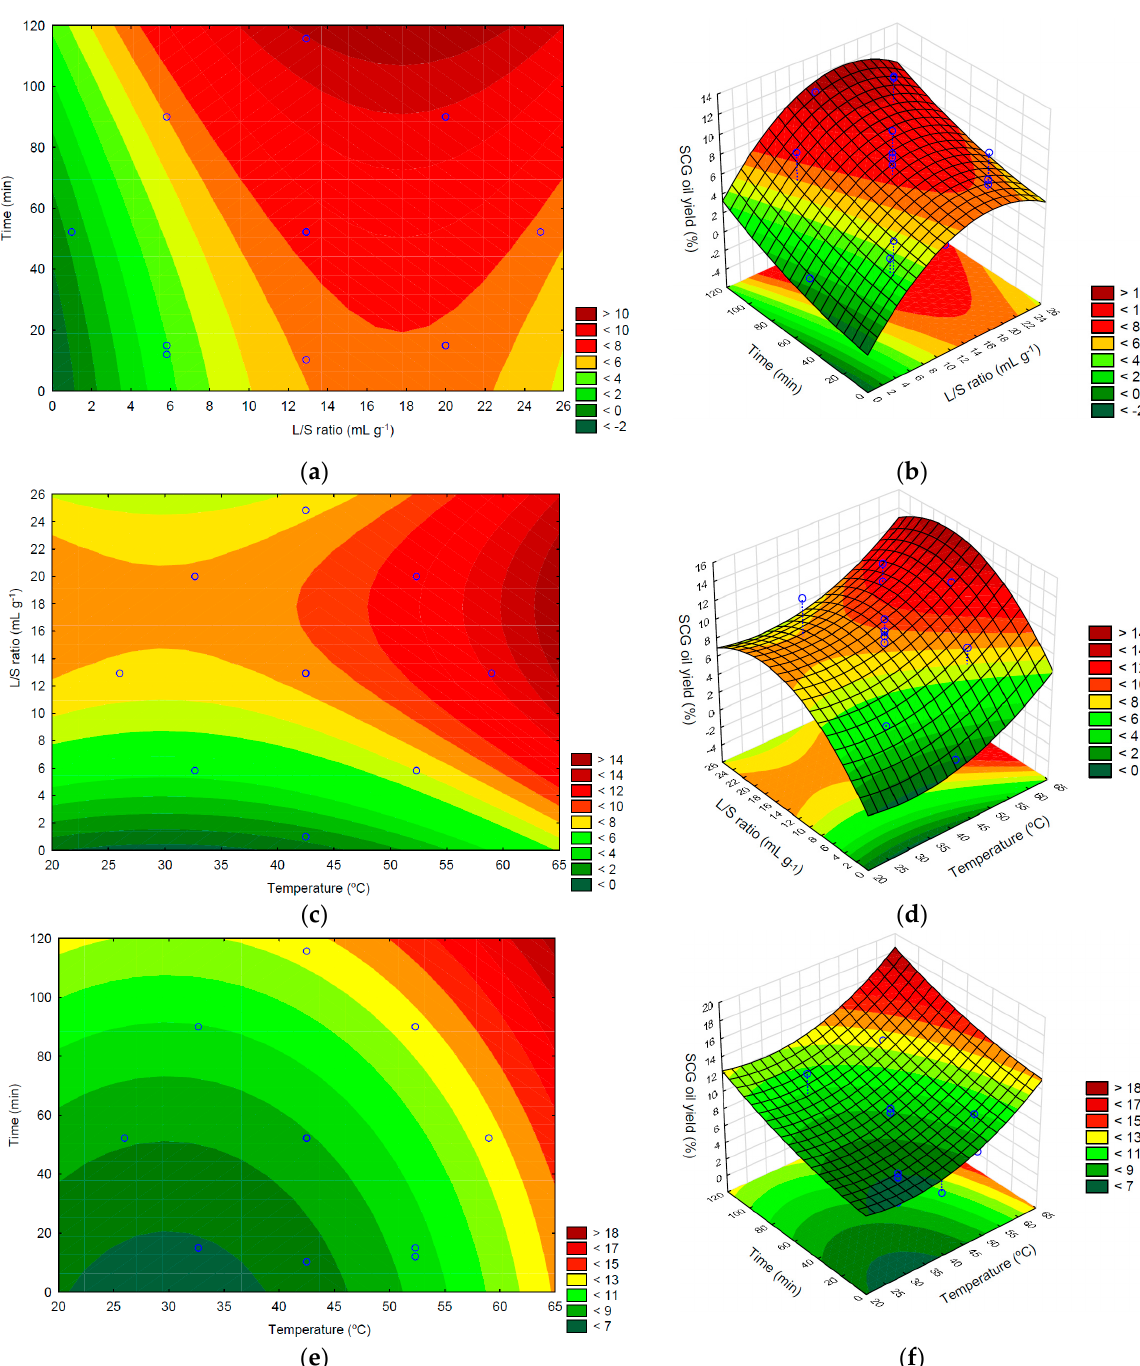
Figure 3. 2D and 3D response surface plots of the SCG oil yield (%), obtained as a function of the combined effect of time (min), temperature (°C) and L/S ratio (mg·g − 1 ) as follows: ( a , b ) extraction time and L/S ratio; ( c , d ) L/S ratio and temperature; ( e , f ) extraction time and temperature.